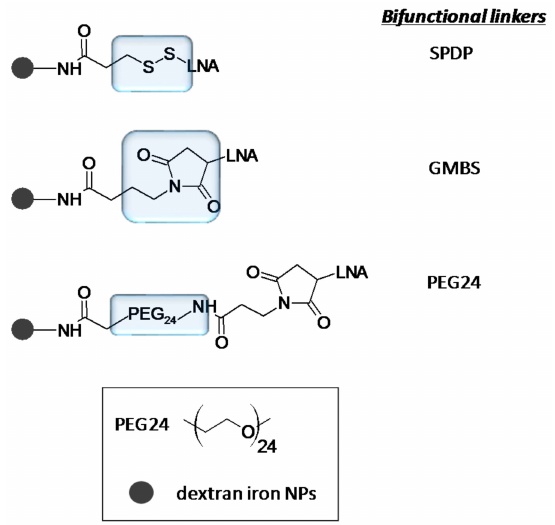
Figure 8. Use of iron NPs functionalized with LNA targeting miR-10b. Structures of three NPs containing SPDP, GMBS and PEG